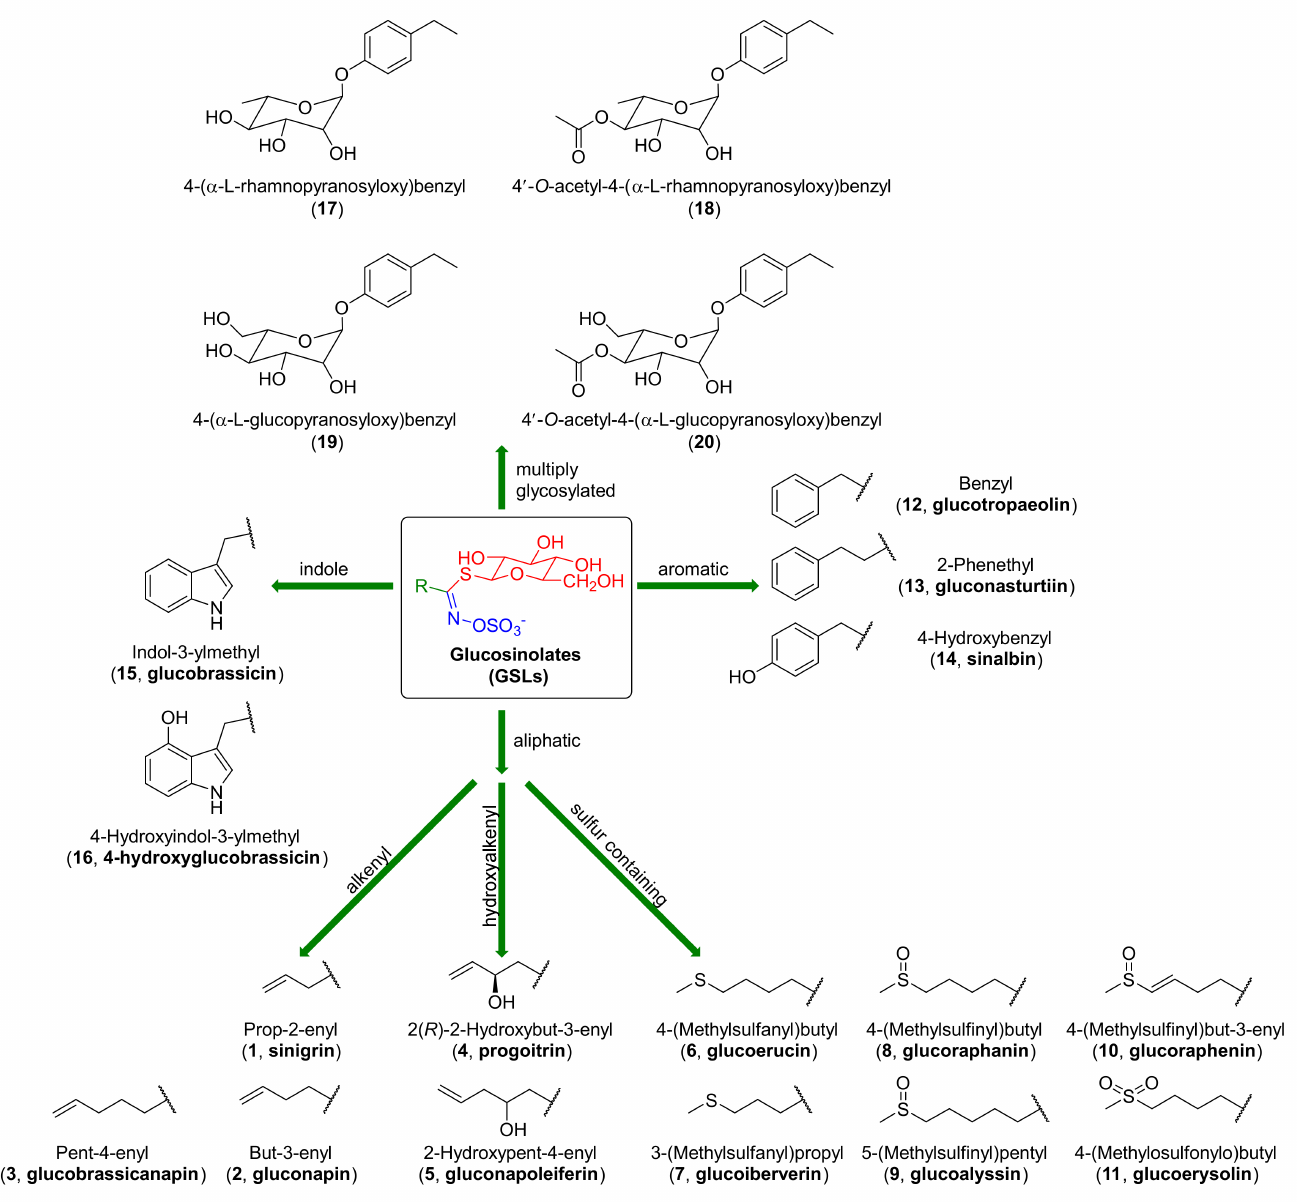
Figure 1. Structures of the main groups of glucosinolates. In plants, GSLs are stored in vacuoles, which protect them against degradation caused by myrosinase ( β -D-thioglucosidase) (EC 3.2.1.1) [24,25]. In plants, the glucosinolate– isothiocyanate system has defense functions against insects, pathogens, and herbivores [26]. Cell damage, e.g., while chewing the plants, results in the formation of a variety of glucosi- nolate breakdown products (Figure 2). In mammals, GSLs are converted to isothiocyanates, through the bacteria present in the digestive tract. Reducing the amount of bacterial flora, as a result of using antibiotics, eliminates this pathway